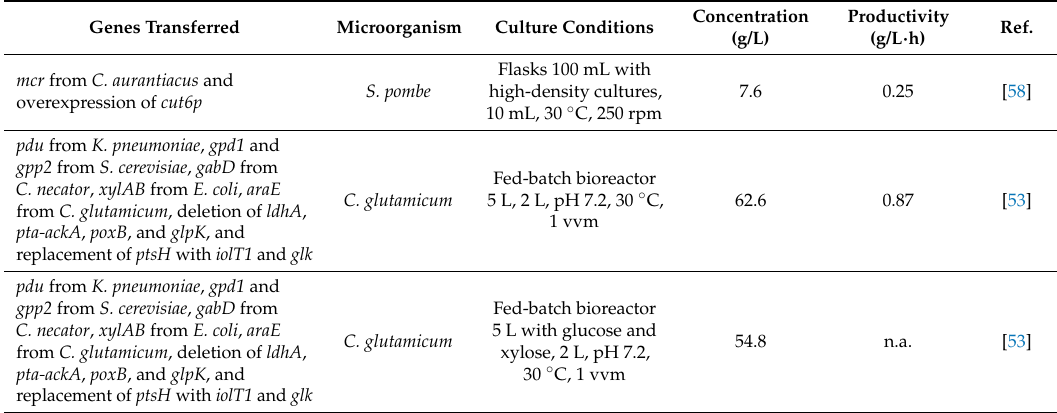
Table 6. Results of 3HP production from glucose using other host microorganisms. Genes Transferred Microorganism Culture Conditions